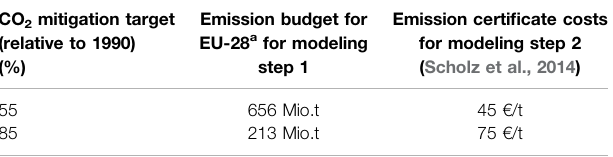
TABLE 2| Cumulated CO 2 emission budgets forpower generation and certi fi cate costs. CO 2 mitigation target (relative to